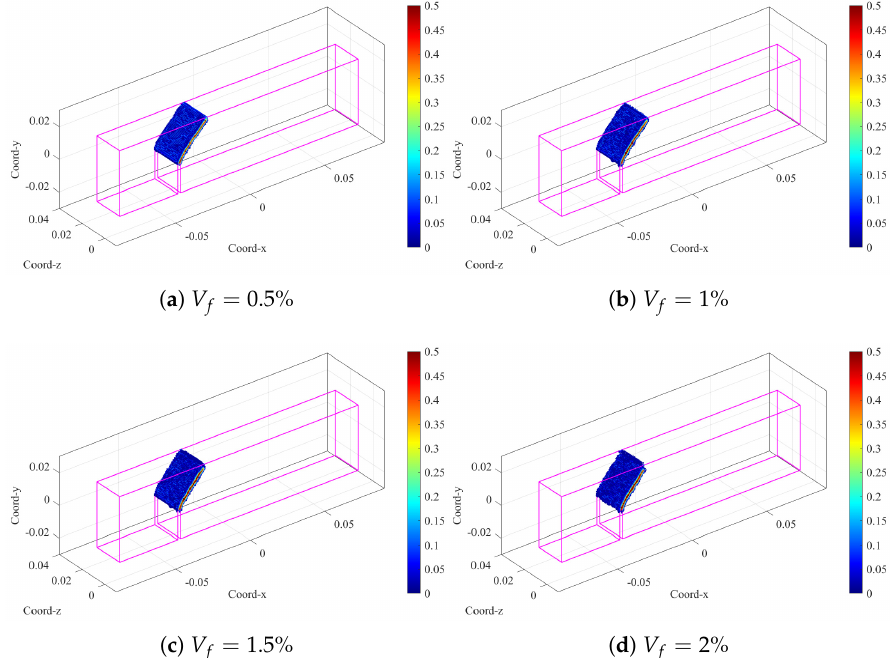
Figure A3. Damage levels in the simulated UHPC-PVA beam specimens with C l = 40